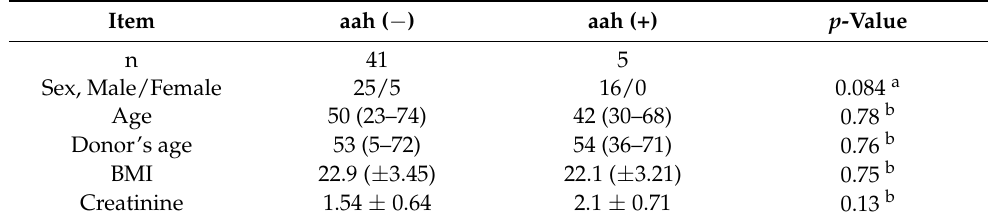
Table A3. Characteristics of participants with aah (+) and aah